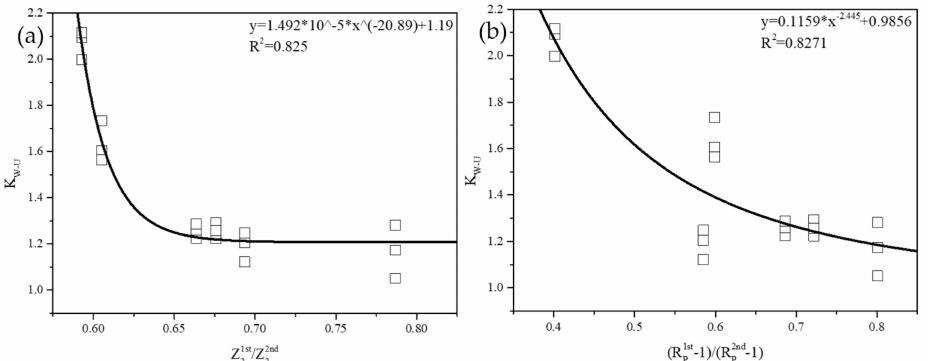
Figure 17. The relationship between the mechanical contribution ratio and the statistical parameter ratio ( a ) K W − U VS . Z 1st